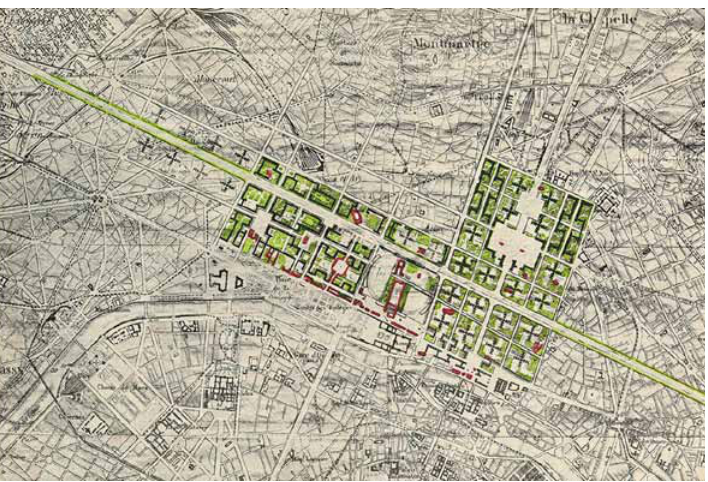
fig. 13. Photography of exhibition taken inside of Esprit nouveau pavilion 1925.